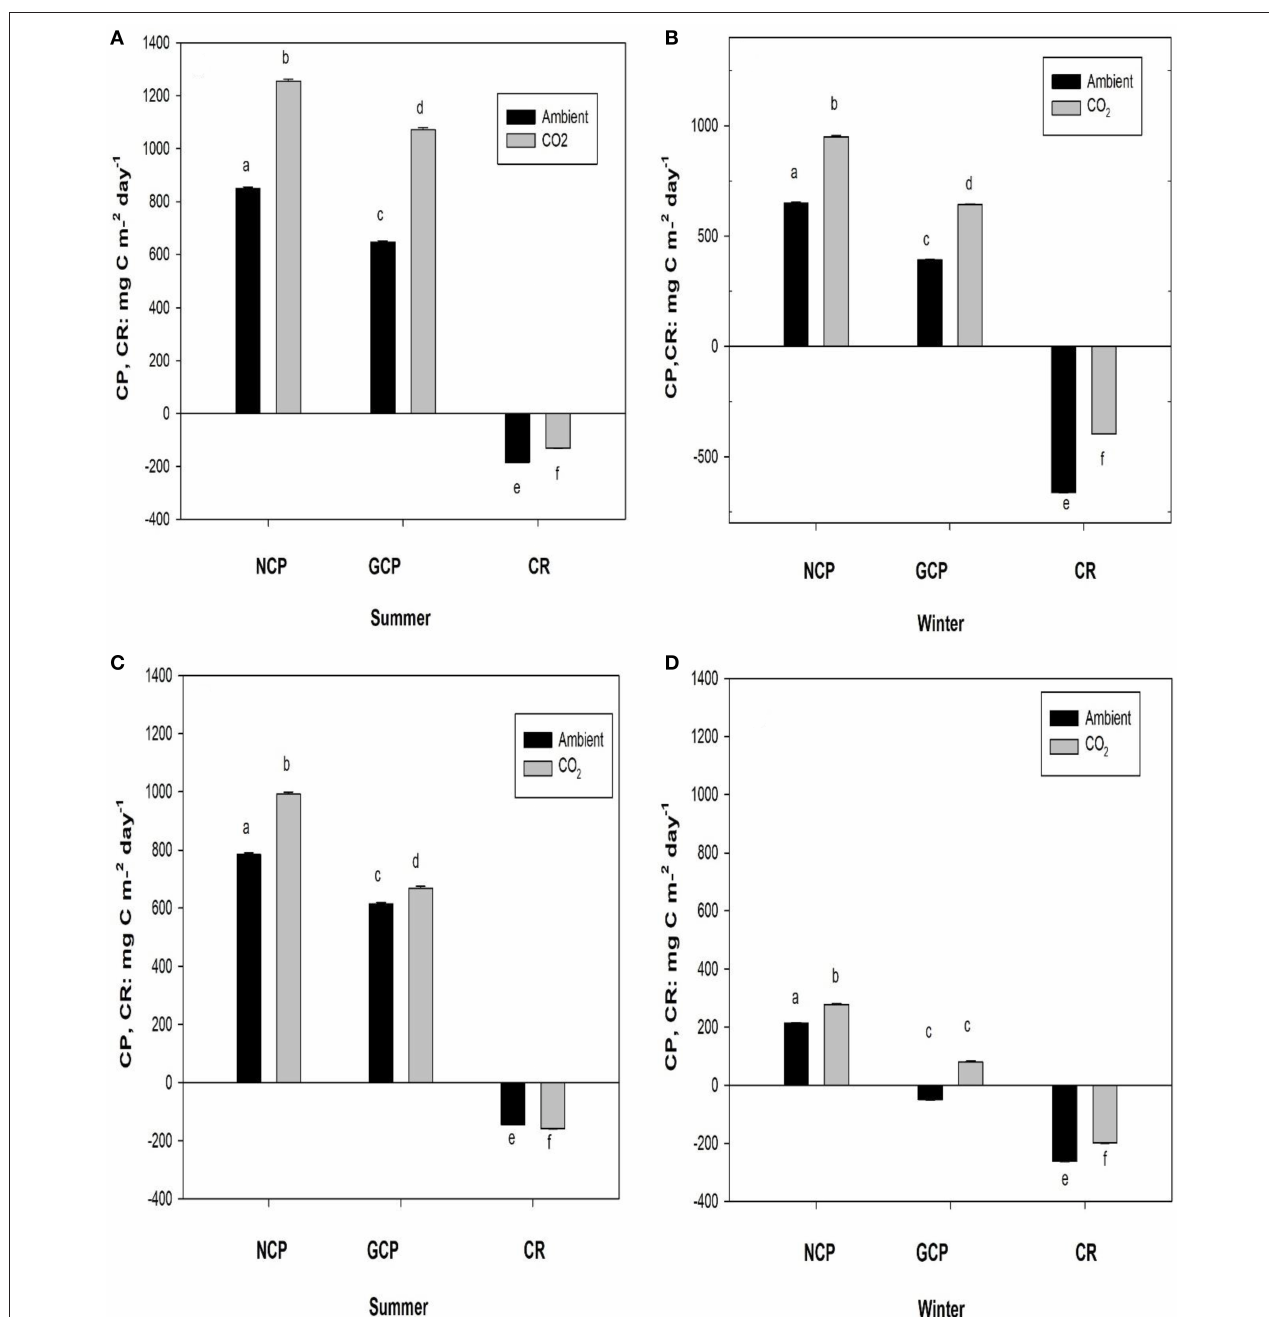
FIGURE 5 | Mean ( ± SE) daily net community production and respiration (NCP at 0 light level) of Z. noltei (A,B) and unvegetated sediment (C,D) in summer and winter seasons under ambient and CO 2 enriched conditions. Different letters indicate significant difference between ambient (air) and CO 2 enriched conditions. Error bars represent standard errors derived from regression models for NCP and GCP and error bars for CR are derived from field measurements.